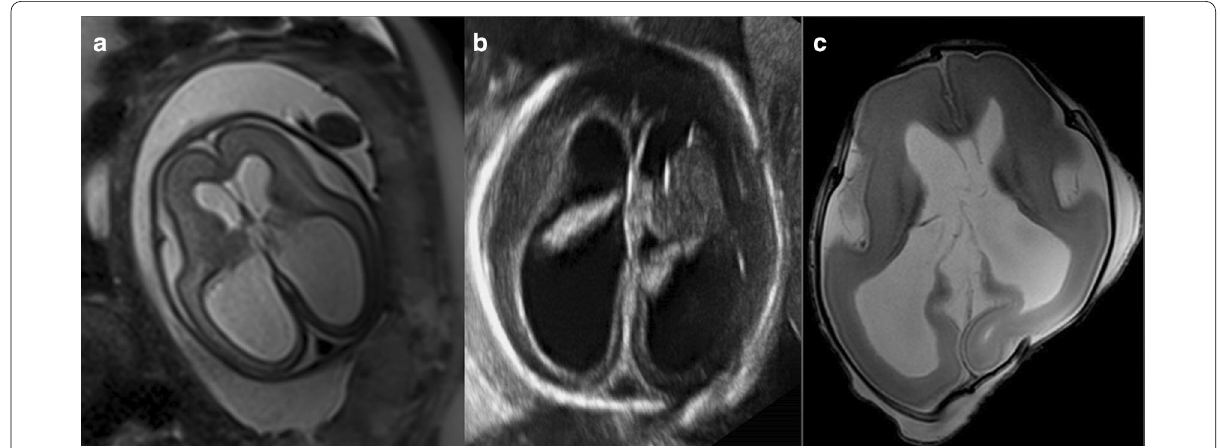
Fig. 6 26‑week, elective termination of pregnancy due to ventriculomegaly. a Intrauterine HASTE MRI sequence showing the ventricular dilation. b Intrauterine ultrasound shows the same findings and ( c ) axial post‑mortem T2W MRI demonstrating the ventricular